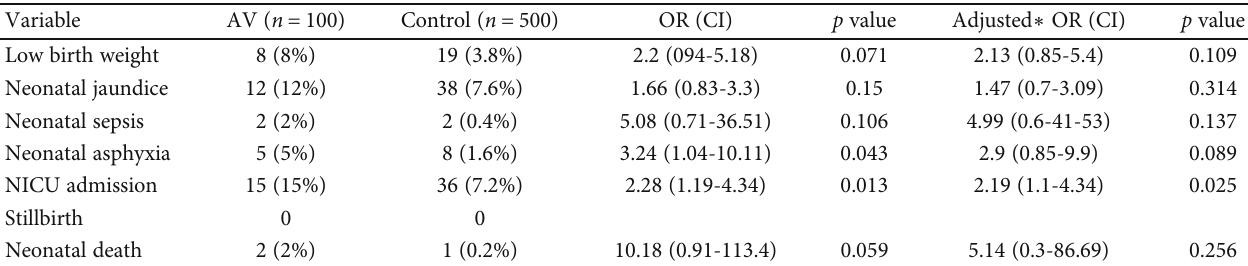
Table 3: Associations of neonatal outcomes among pregnant women with aerobic vaginitis and without aerobic